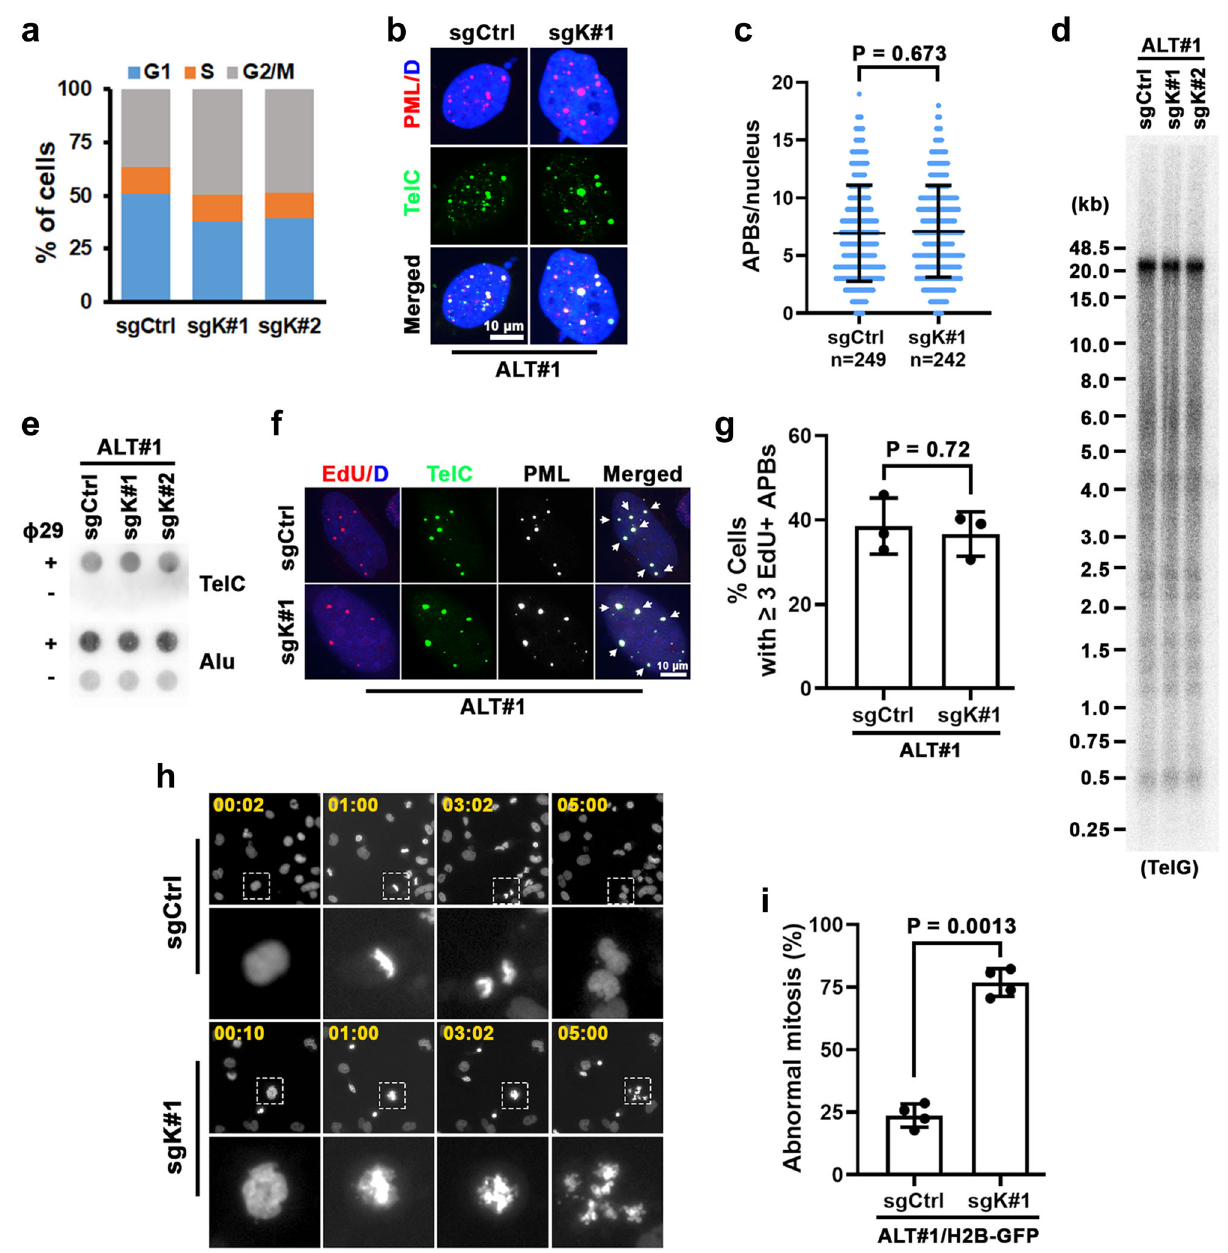
Fig. 5 | KDM2A depletion disrupts ALT chromosomal segregation and mitotic division. a Cell cycle distribution analysis of sgCtrl, sgK#1 or sgK#2-transduced ALT#1 cells. b Representative immuno-FISH images of ALT-associated PML bodies (APBs) in sgCtrl or sgK#1-transduced ALT#1 cells. Scale bar=10 µ m. c Percentages of cells containing ≥ 4 APBs are expressed as mean±s.e.m. of three independent experiments;two-tailedunpaired t -test. d Telomererestrictionfragmentanalysisof telomerelength of sgCtrl, sgK#1, or sgK#2-transduced ALT#1 cells. GenomicDNAs prepared from the indicated cells were assayed by a 32 P-labeled TelG probe. e C-circle assays of sgCtrl, sgK#1 or sgK#2-transduced ALT#1 cells. Genomic DNAs were prepared from the indicated cells and assayed by a 32 P-labeled TelC probe. f Representative immuno-FISH images of EdU colocalized APBs (EdU-APBs) in sgCtrl or sgK#1-transduced ALT#1 cells. Cells were synchronized in G2 with